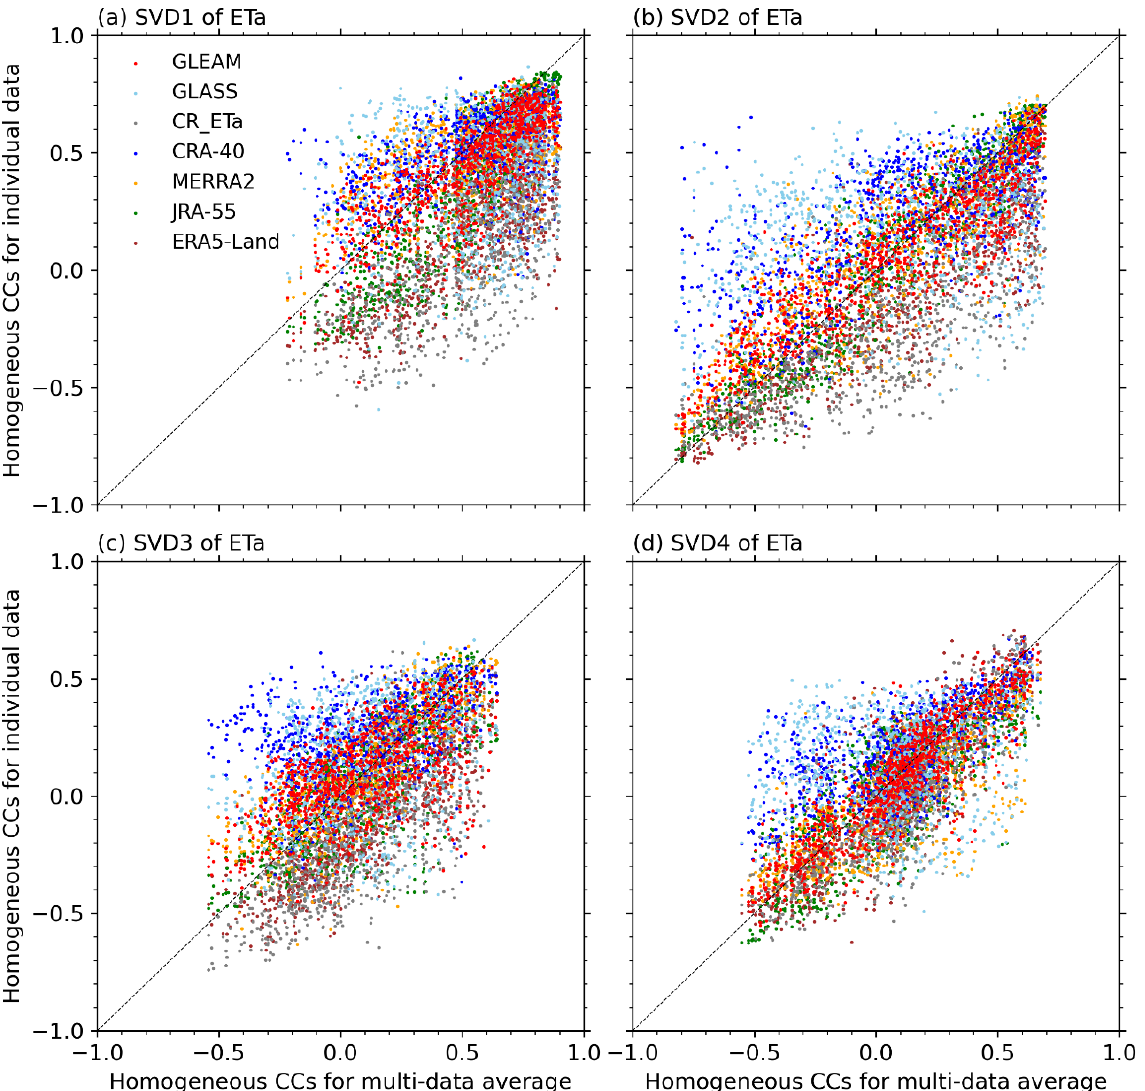
Figure 7. The same as Figure 4 but for the homogeneous correlations (homogeneous CCs) of the first four leading SVD modes of ETa: ( a ) SVD1, ( b ) SVD2, ( c ) SVD3, and ( d ) SVD4.